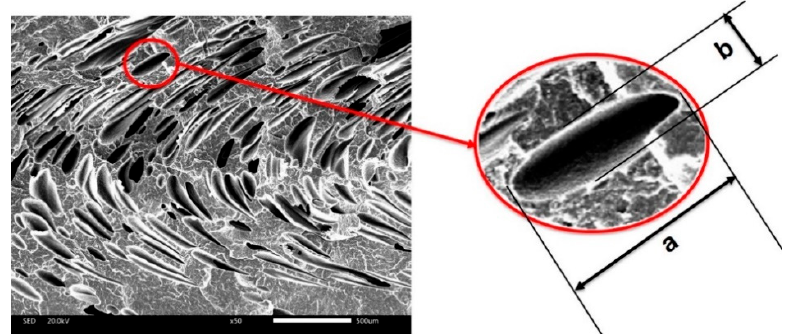
Figure 3. The length and diameter of a cell.